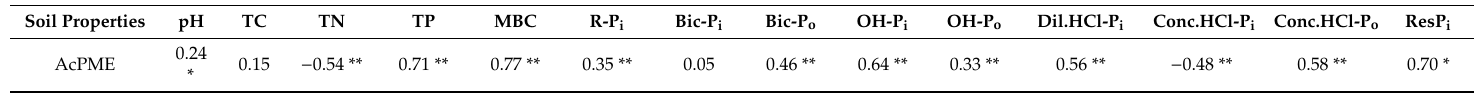
Table 3. Coe ffi cient (r) for the Pearson’s correlation between soil acid phosphomonoesterase (AcPME) and soil properties in L. principis - rupprechtii plantations. Soil